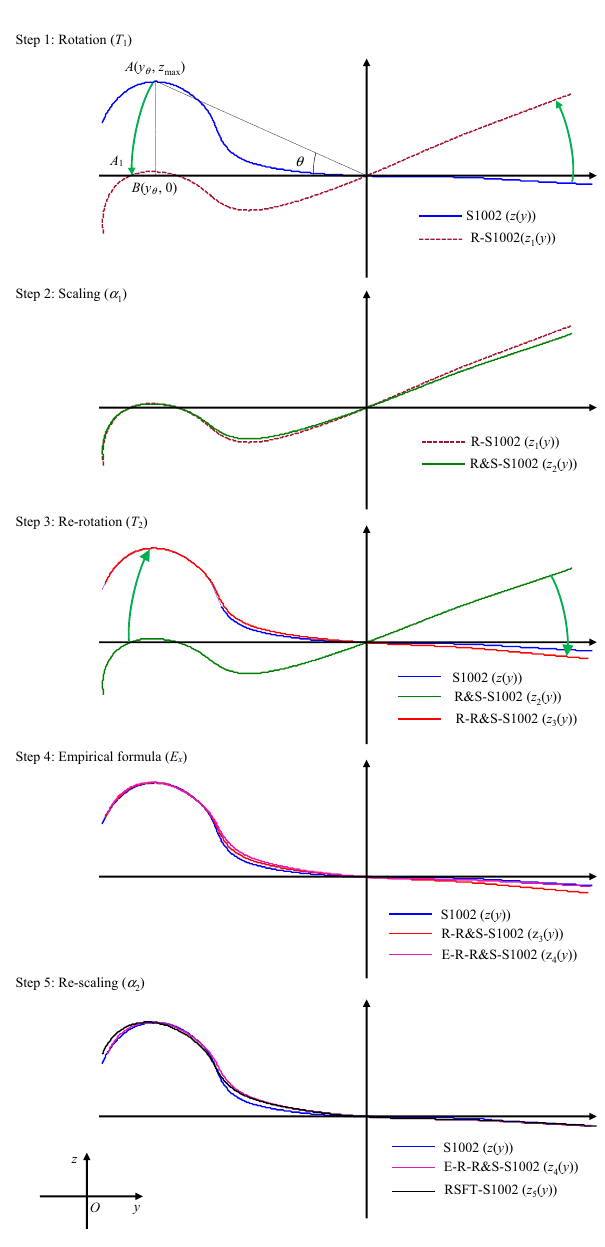
Fig. 6 RSFT method for wheel profile generation (an example of